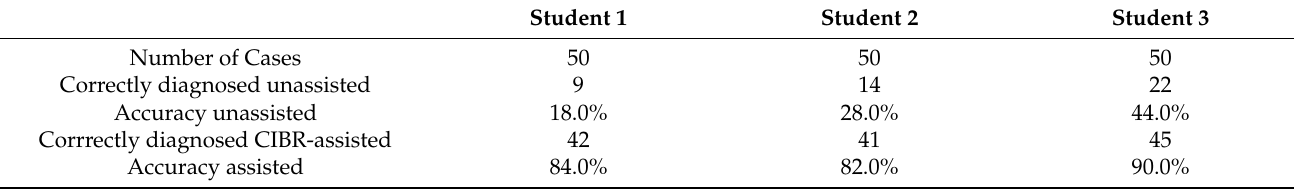
Table 1. Results of the students’ accuracy. All students’ accuracies in the unassisted test runs proved to be significantly different ( p < 0.01) from the CBIR-assisted test runs.